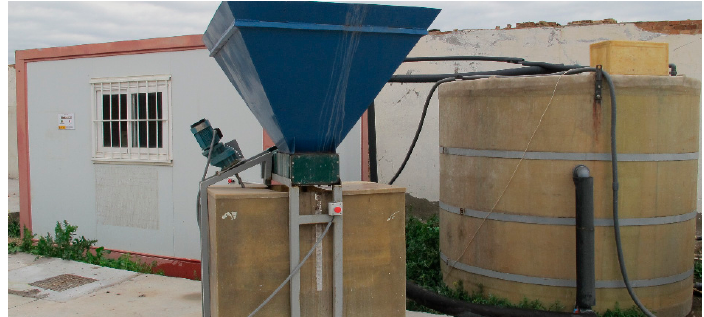
Figure 12. The small ‐ scale prototype. The photograph shows the control house, the pretreatment unit, and the anaerobic reactor. and the anaerobic